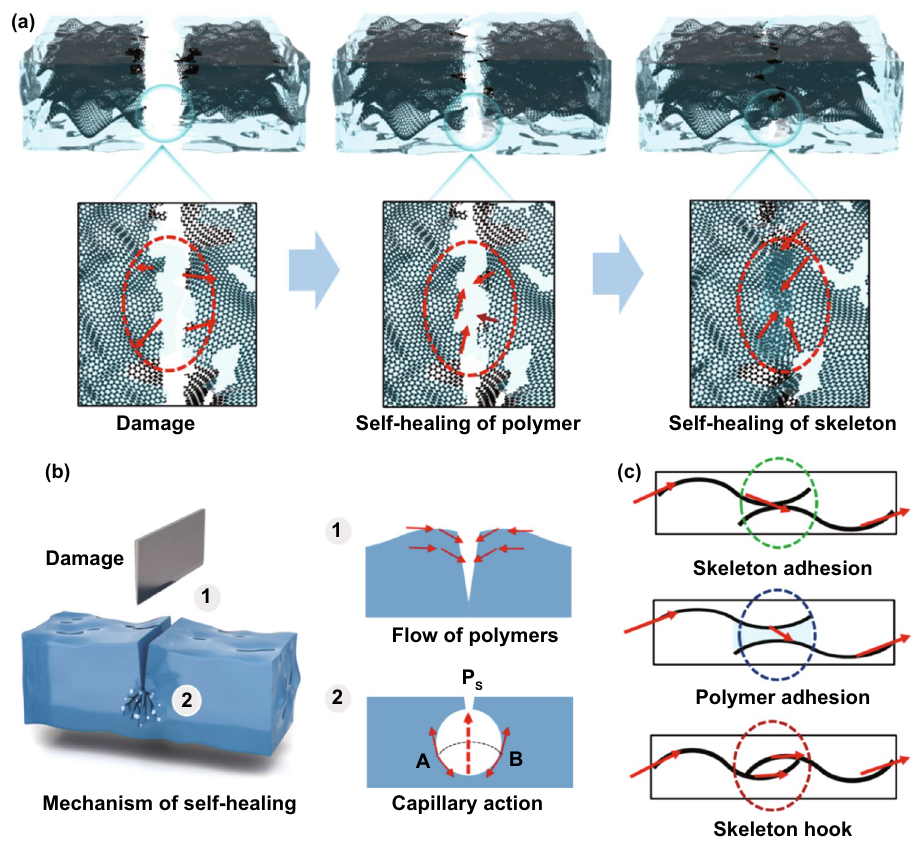
Fig. 5 a Schematic of the self-healing process of PBA–PDMS/FGf. b Self-healing mechanism of macroscopic damage to materials. c Self- healing mechanism of PBA–PDMS/FGf for thermal